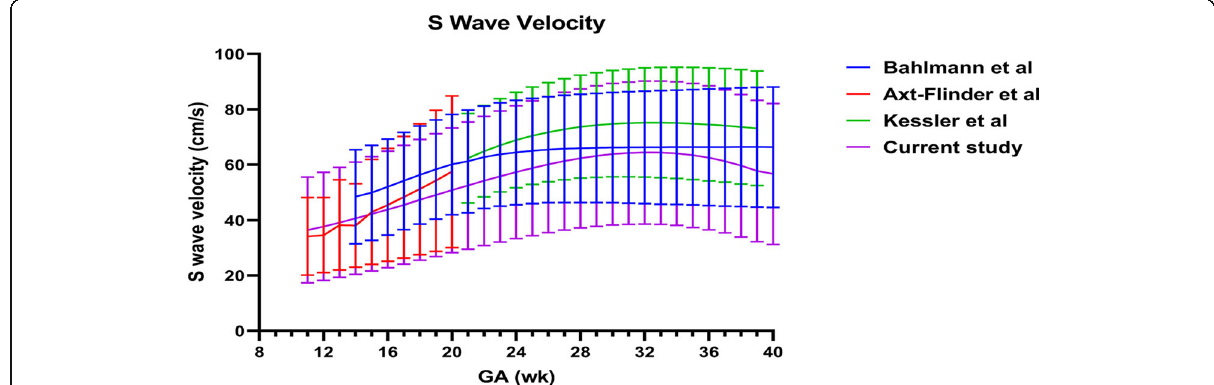
Fig. 8 Gestational age-related reference intervals for S wave velocity estimated by the current study as contrasted with those obtained from previous